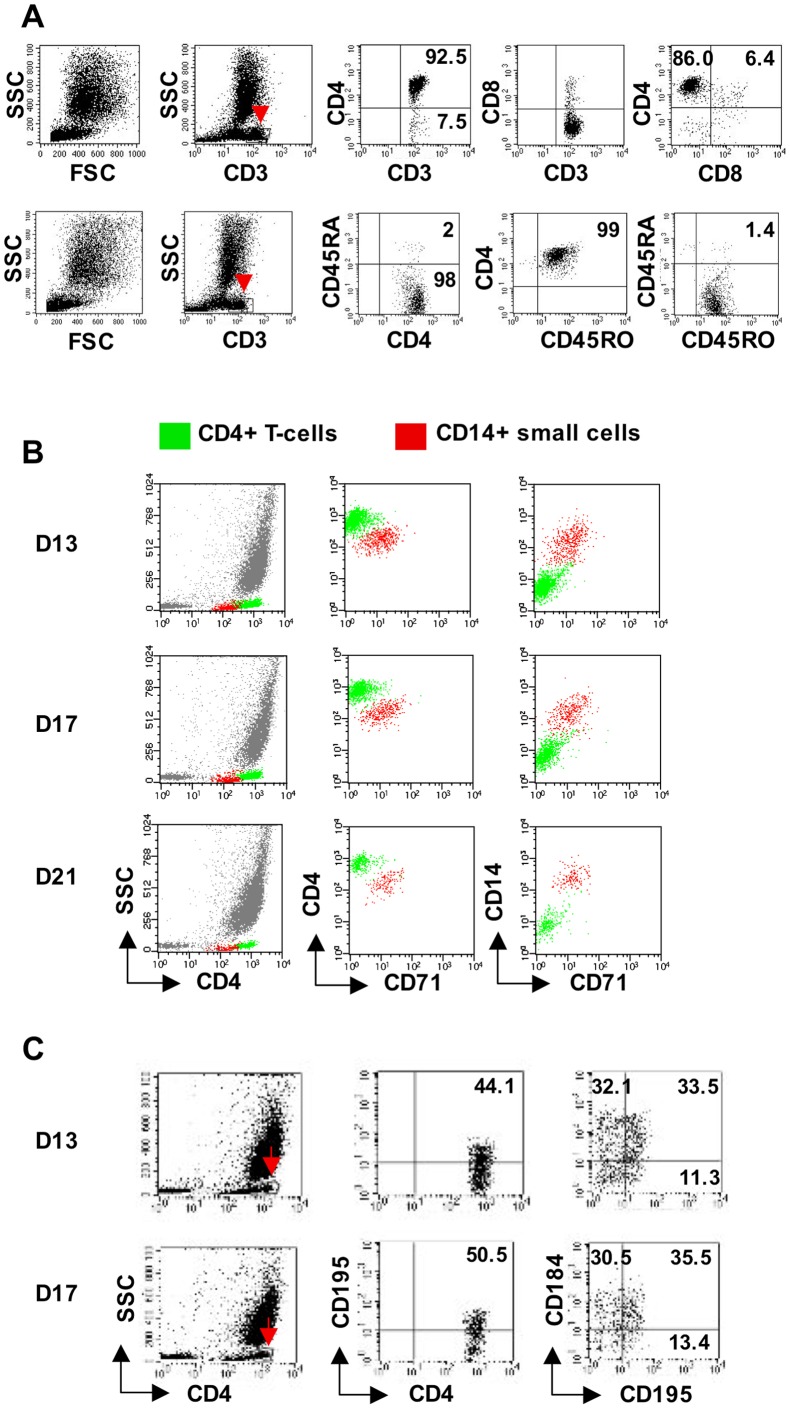
Characteristics distinguishing CD4+ T-cells produced in primary macrophage cultures from those produced in EDTA/IL2-mac.(A) As was the case in cultures of replated EDTA-mac treated with IL-2, the vast majority of T-cells produced in primary MDM cultures were also CD4+ T-cells. This is depicted here. However, in contrast to IL-2 treated cultures, these CD4+ T-cells were almost exclusively CD45RO+ and lacked CD45RA. Cells shown here were harvested on day 13 of culture and gated based on small size and CD3 expression (red arrows). The forward versus side scatter plots on the left demonstrate the relative numbers of large macrophages and lymphocytes within the nonadherent cell population. The numbers shown within the quadrants represent percentages from among the gated populations. (B) In contrast to those recovered from EDTA/IL2-mac, as shown here, the CD4+ T-cells produced in primary macrophage cultures did not express CD71, the transferrin receptor, indicating that they were resting lymphocytes. The CD71+ cells apparent are small CD4dim/CD14+ monocytoid cells, not lymphocytes. Analyses performed using Paint-a-Gate software. (C) Also in contrast to the CD4+ T-cells produced in IL-2-treated cultures, as shown here, 40–50% of these cells produced in primary MDM cultures expressed CD195, and 30–35% were dual positive for CD195 and CD184. Gates for the dot plots shown were established based on CD4bright expression and low side scatter, as indicated in the left panels (red arrows). Small, CD4dim cells were excluded from the gates because these were small monocytoid cells, not T-cells. The numbers shown within the quadrants represent percentages from among the gated populations. Analyses performed using CellQuest software. For (B) and (C), the letter D refers to the age of the culture in days at the time of harvest.